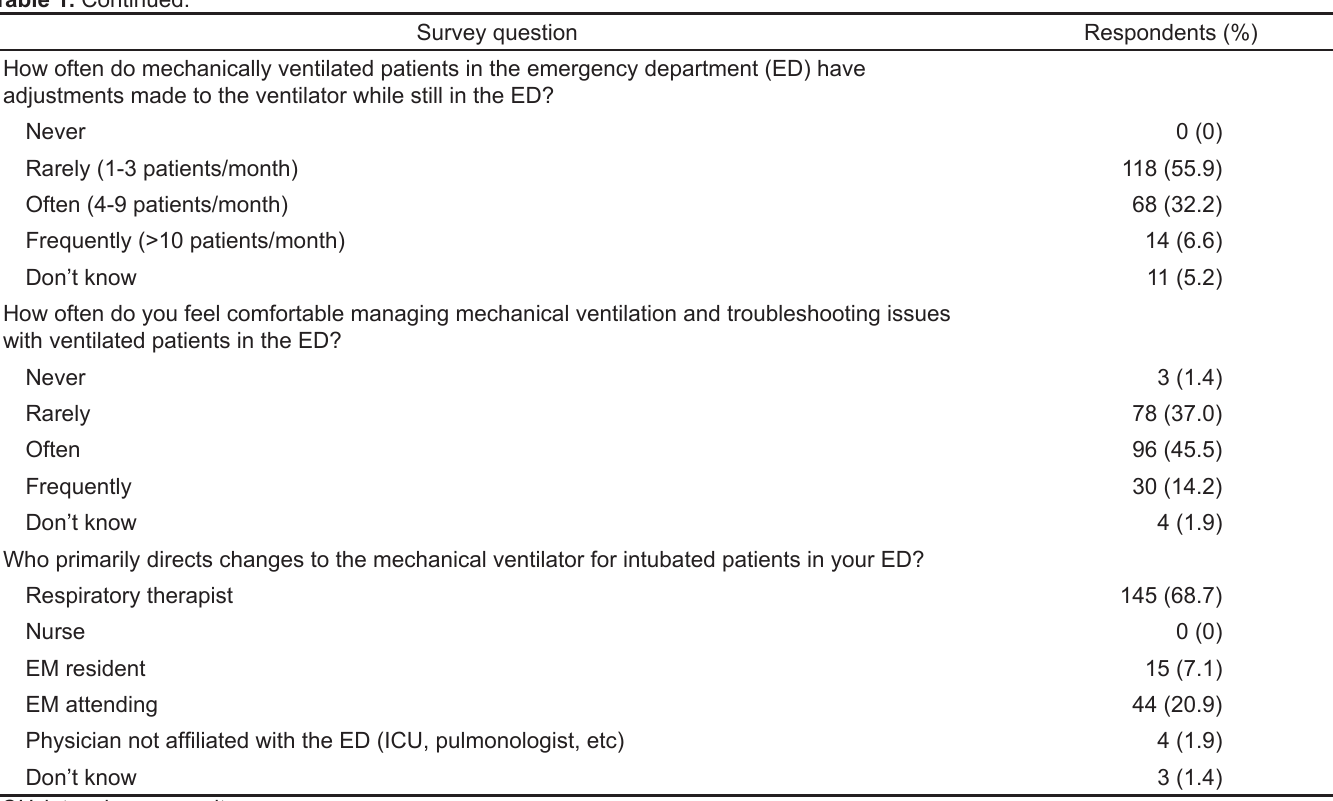
Table 2. Correlations between survey responses and total score on assessment tool.